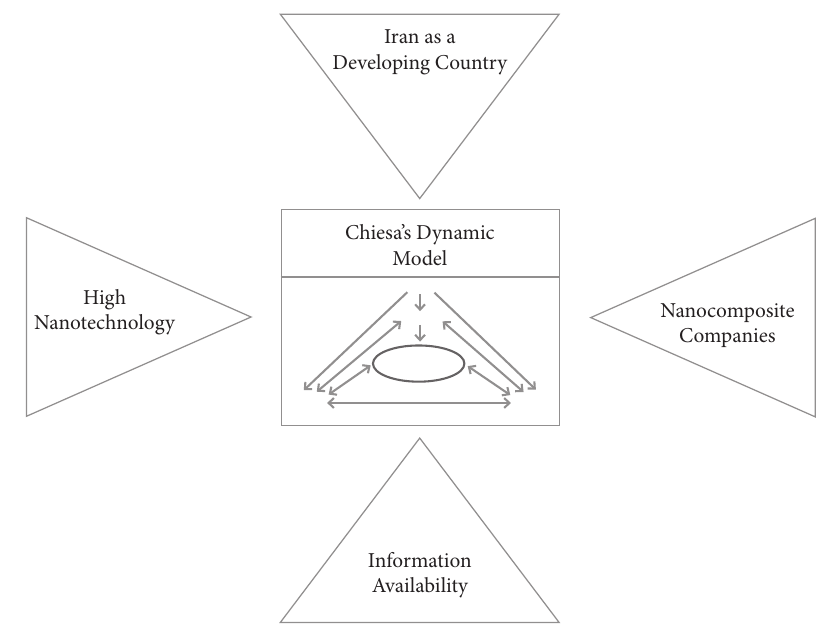
Fig. 2. Key internal and external environmental moderators of comparative